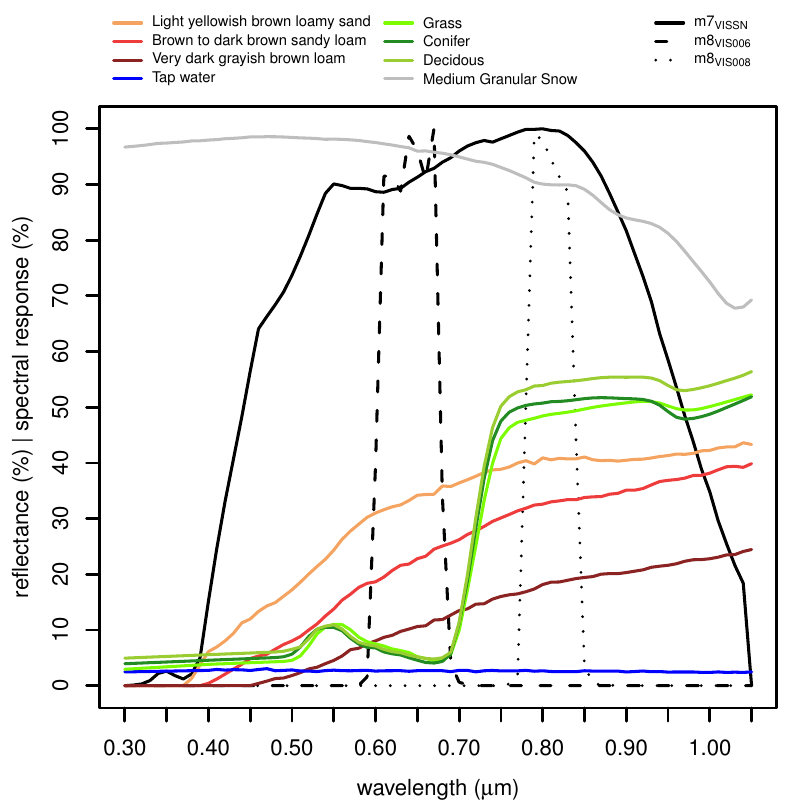
Figure 1. Spectral response functions for the Meteosat-7 (M7) and Metoesat-8 (M8) visible channels and the spectral reflectance for various